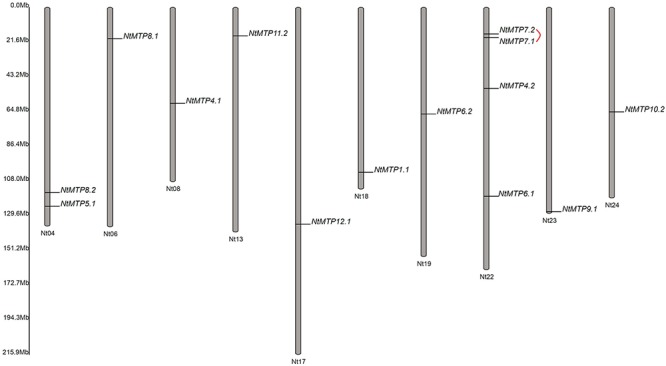
The distributions of NtMTP genes on N. tabacum chromosome. Chromosome number was indicated at the bottom of each chromosome, and the size of which was labeled on the left of the figure. Segmental duplicated gene pair was linked with red line.